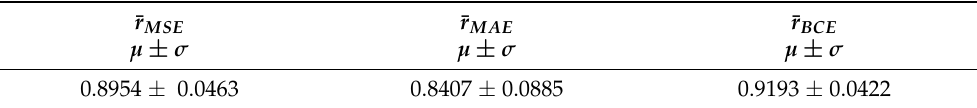
Table 10. Mean Pearson Correlation on test set.